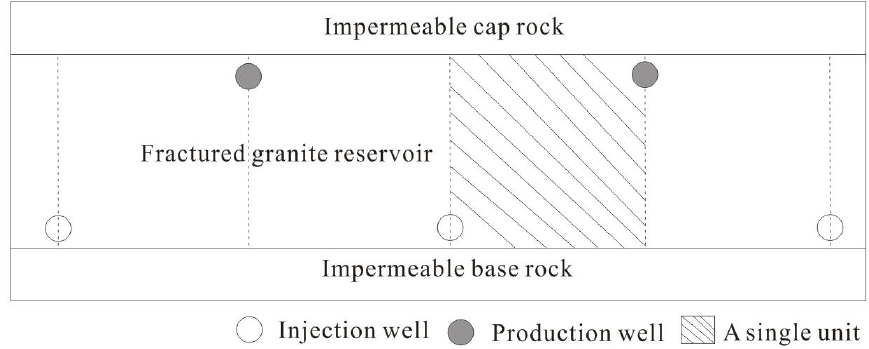
Figure 2. Well arrangement of the 950~1350 m fractured granite reservoir.